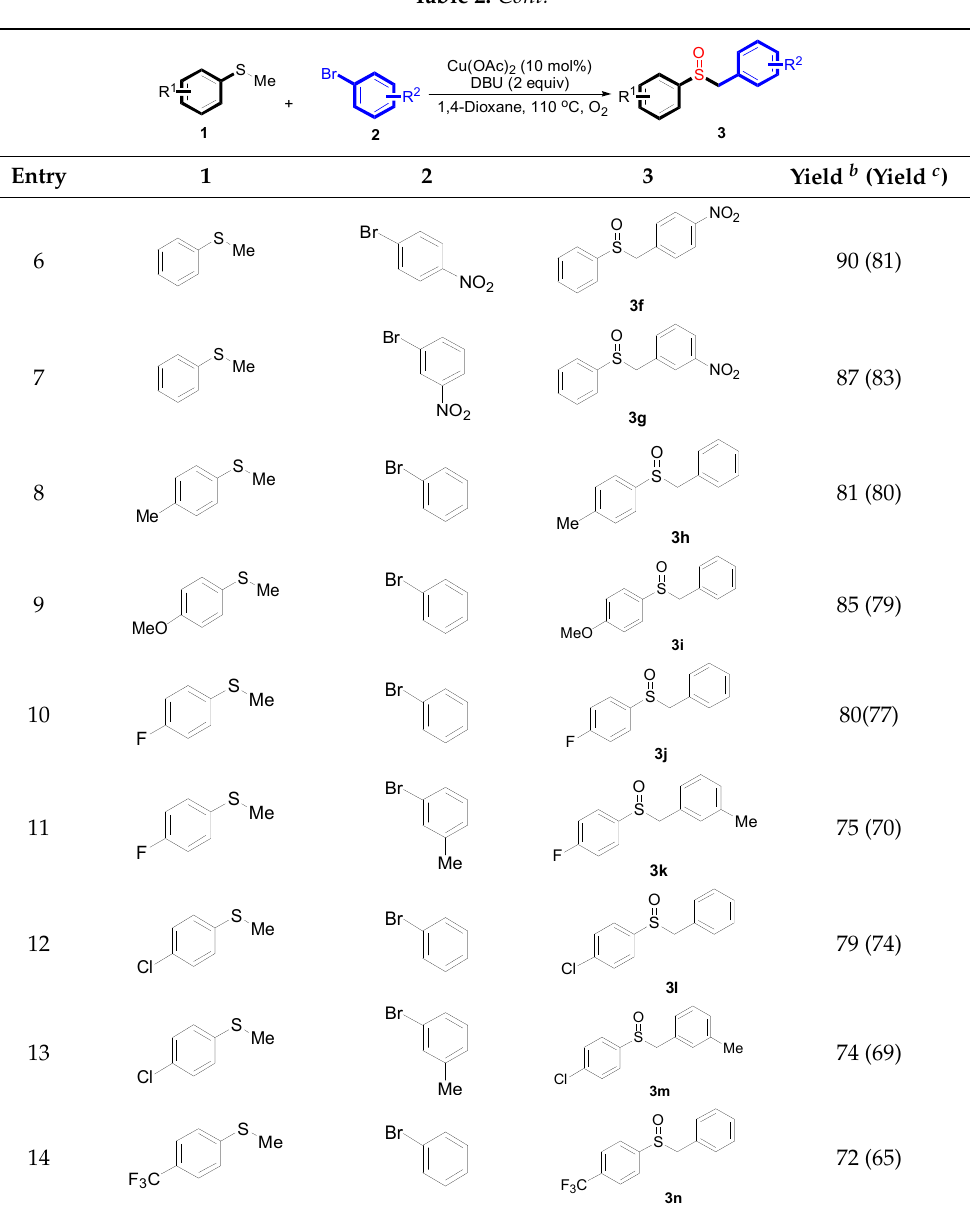
Table 1. Optimization of the reaction conditions a . Table 2. Cont. Table 2. Copper-catalyzed sulfoxidation of thioanisoles 1 with bromobenzenes 2 a .